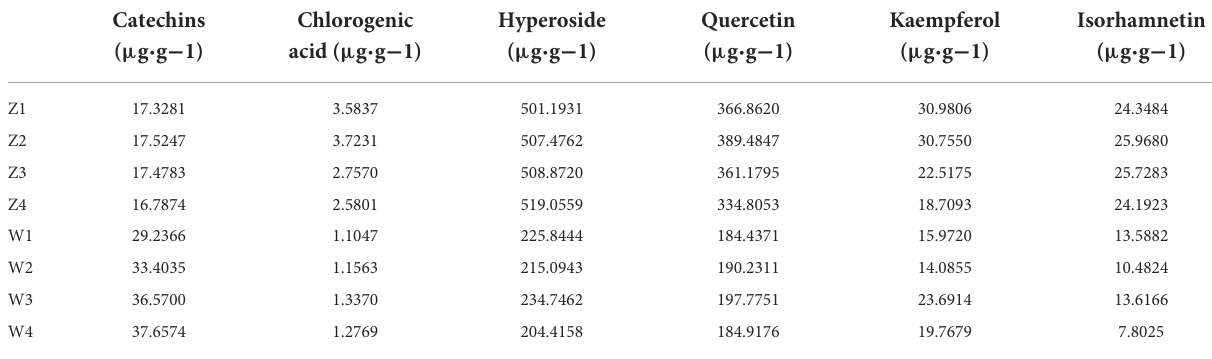
TABLE 3 The content of the six compounds in ZP and WP.